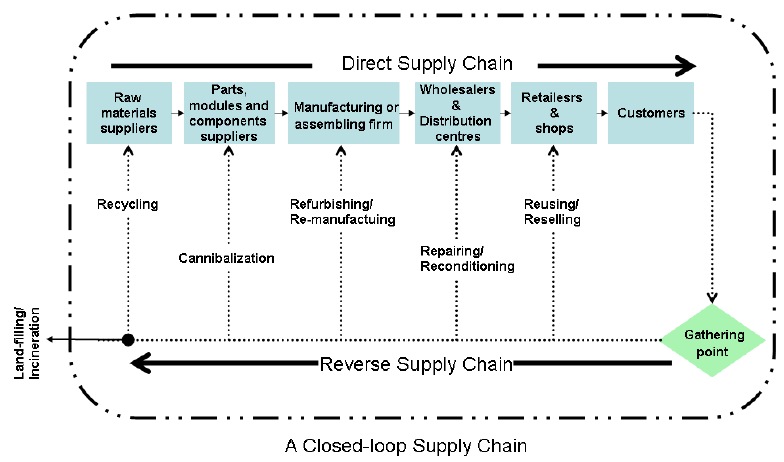
Figure 3: Direct, Reverse and Closed-Loop Supply